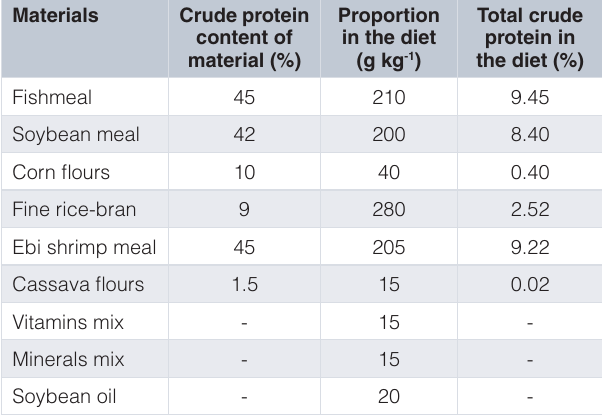
Table 1. The raw materials of the formulated diet containing 30% protein used in the study. Materials Crude protein content